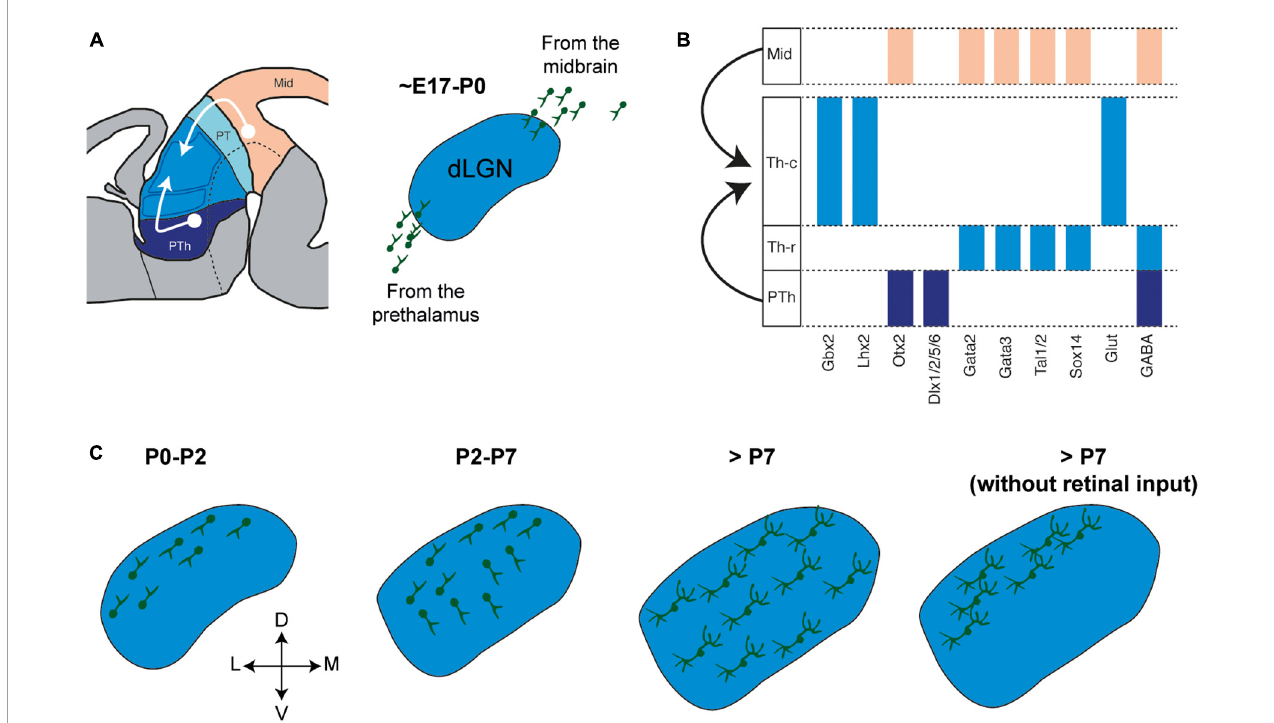
FIGURE3 Integration of local thalamic interneurons from extra-thalamic sources. (A) Right , Schema showing the migration toward the thalamus of prospective local interneurons born in the midbrain and prethalamus. Left , Prospective local interneurons start invading the developing mouse dLGN shortly before birth. (B) Representative expression patterns of transcription factors, specially lineage selector genes, in precursor cells from prosomere 2 and GABA lineages from prosomere 3 and midbrain. (C) Schema of a mouse dLGN showing sequentially how local interneurons migrate and distribute into the nucleus in control conditions and upon deprivation of retinal input (Golding et al., 2014; Charalambakis et al., 2019; Su et al., 2020).